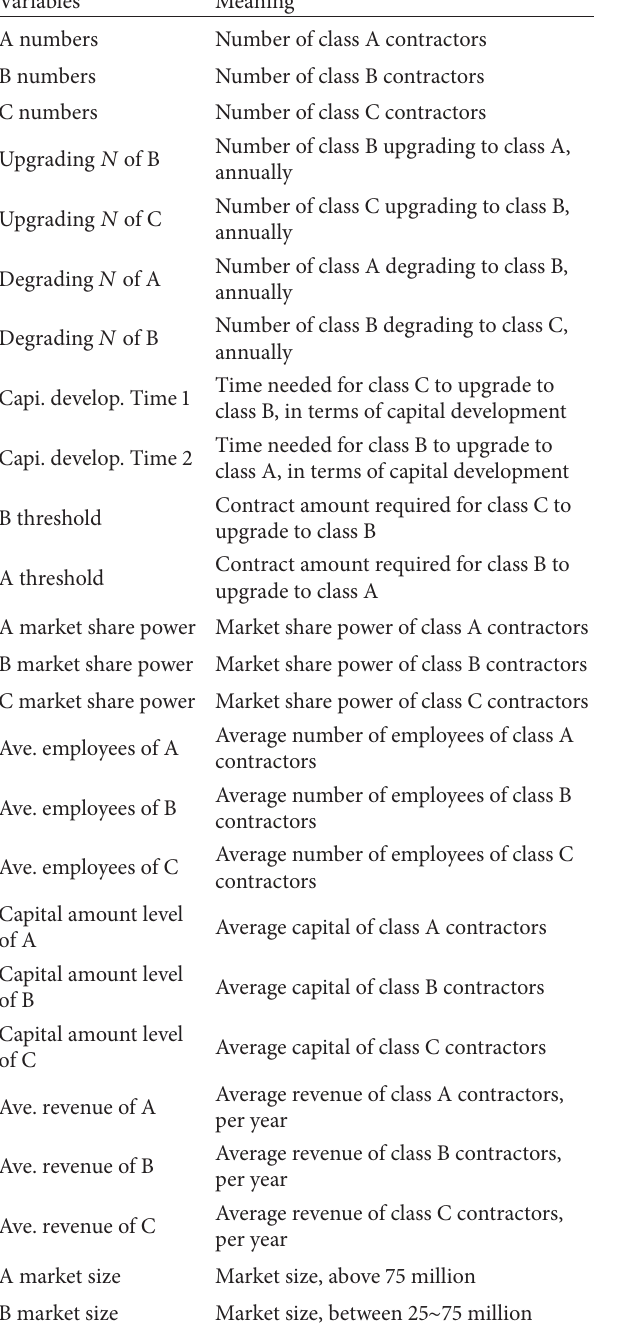
Table 3: Comparison between simulated and actual numbers of contractors.